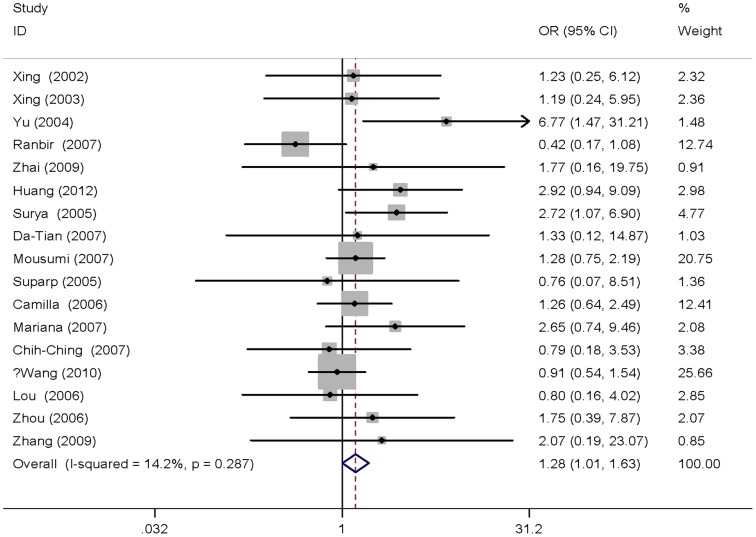
Forest plot of digestive cancer risk associated with the XPD Lys751Gln polymorphisms in Asian subgroups (based on homozygote comparison).A fixed-effects model was used. The squares and horizontal lines correspond to the study-specific OR and 95% CI. The area of the squares reflects the weight (inverse of the variance). The diamond represents the summary OR and 95% CI.